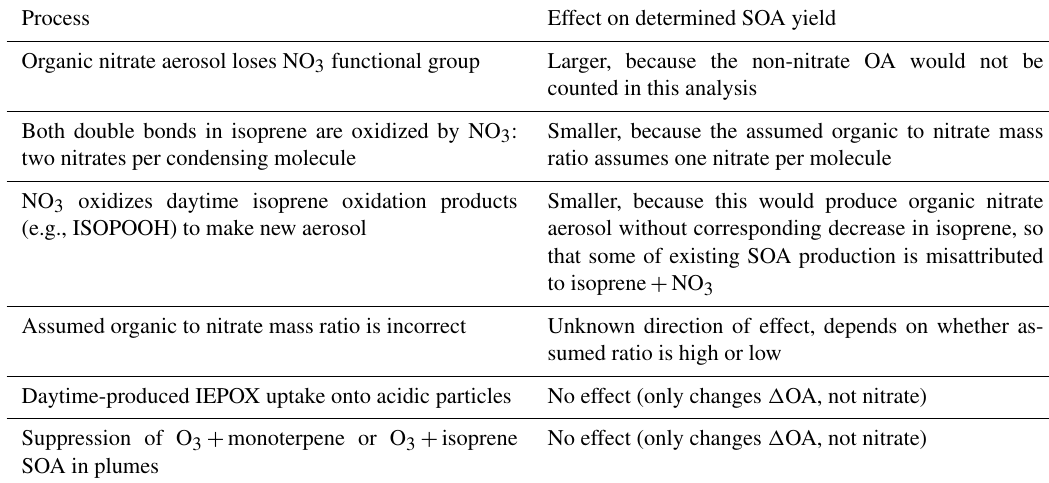
Table 3. Several caveats to the present SOA yields analysis are listed below, alongside the expected direction each would adjust the estimated yields. As we do not know whether or how much each process may have occurred in the studied plumes, we cannot quantitatively assess the resulting uncertainties, so we simply list them here. See text above for more detailed